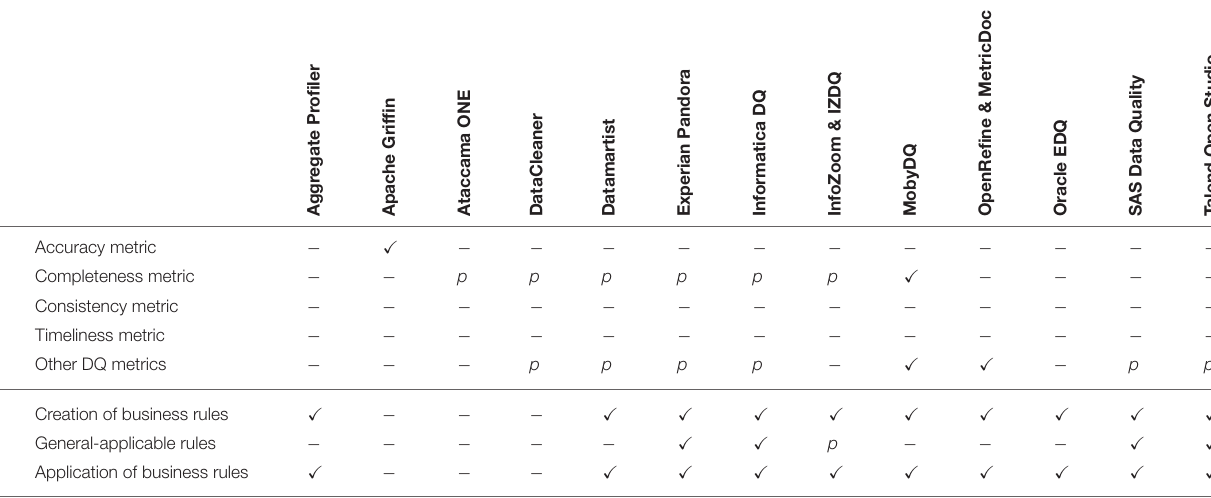
TABLE 9 | Data quality measurement